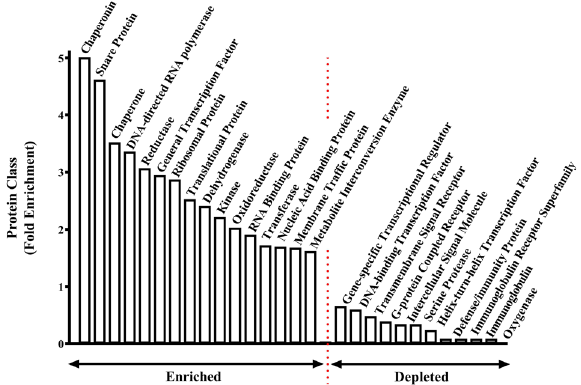
Fig. 2 Protein classes affected by changes in gene expression in the Chrm1 − / − mouse. Protein classes containing enriched or depleted levels of genes with altered levels of expression in the cortex of Chrm1 − / − mouse.